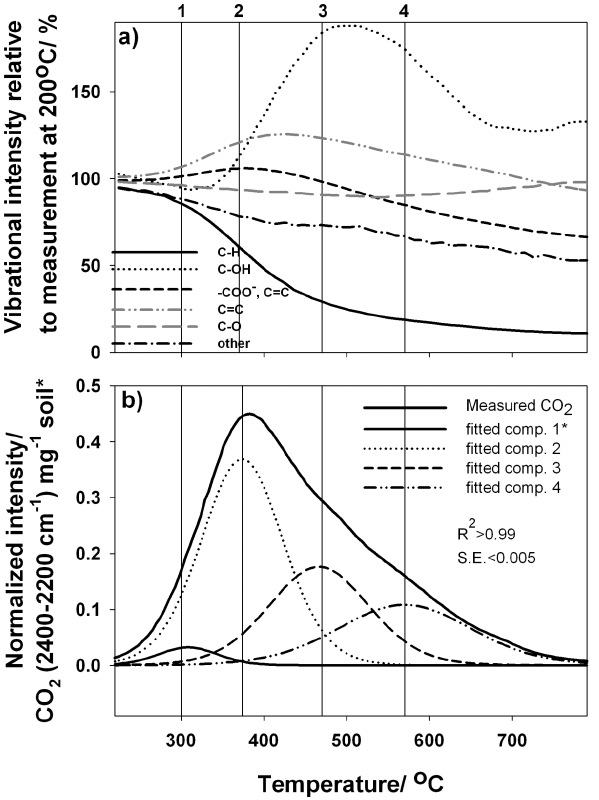
Figure 11 Fig. 11. Summary of qualitative changes in organic functional groups during heating as a guide to fitting components to quanti- tative evolved gas anlaysis: (a) in situ T DRIFTS measurements of bulk soil from the Kraichgau site as a percentage of the vibrational intensity at 200 ◦ C to identify temperature of maximum change of functional groups. (b) Peak fitting with four components of evolved gas profile as measured by FTIR-EGA of bulk soil from Kraichgau site using previously identified temperatures of maximum change of functional groups. Statistics are from the goodness of fit of the four fitted components to the measured data. Reference lines 1 to 4 indicate the peak of the fitted components of the FTIR-EGA gas profile in Fig. 6b. ∗ Normalized intensity is the integrated area of the CO 2 peak from 2400 to 2200cm − 1 normalized to weight of the